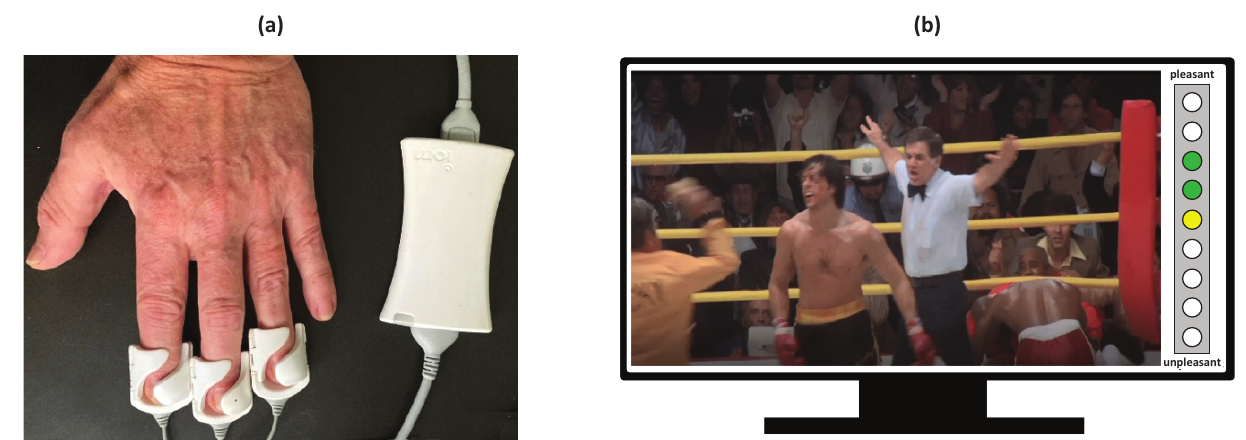
Figure 2. Methods to capture participants’ continuous responses: (a) Commercial sensor; (b) onscreen RTR